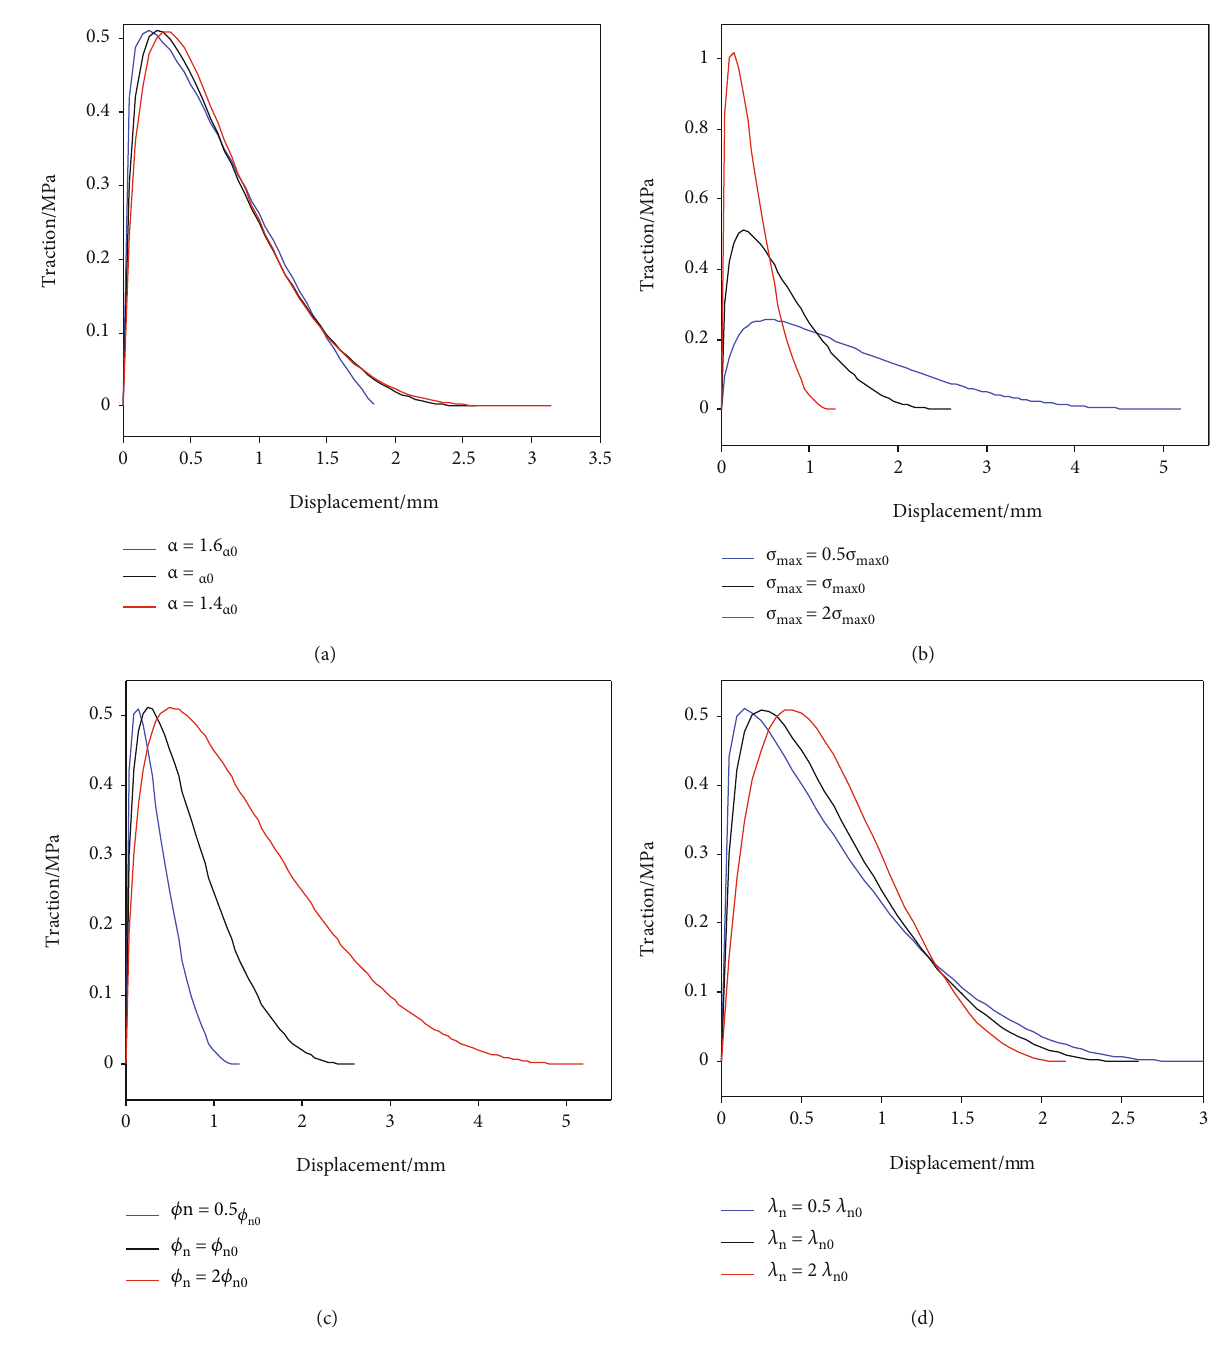
; (c) ϕ n ; (d) λ n max